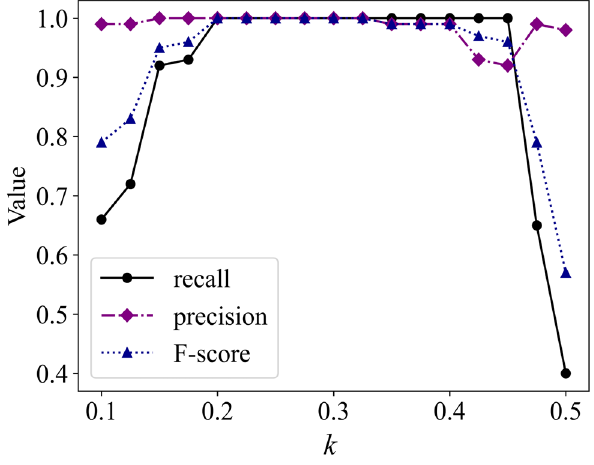
Figure 10. Location detection accuracy versus parameter k .